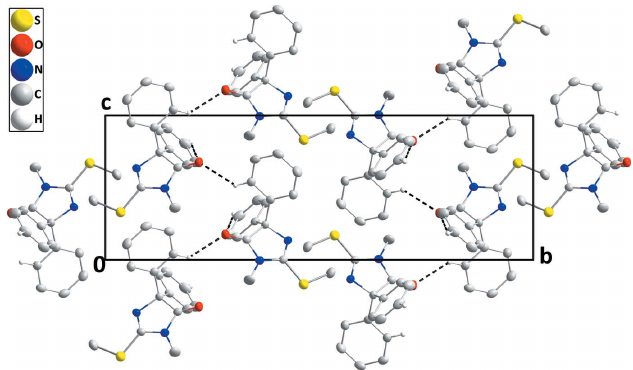
Figure 2 A portion of one layer viewed along the b -axis direction with C—H (cid:2)(cid:2)(cid:2) O hydrogen bonds depicted by dashed lines. Non-interacting hydrogen atoms are omitted for clarity.